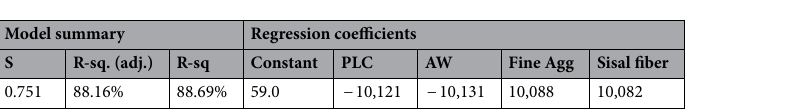
Table 7. Multiple linear regression statistical results.